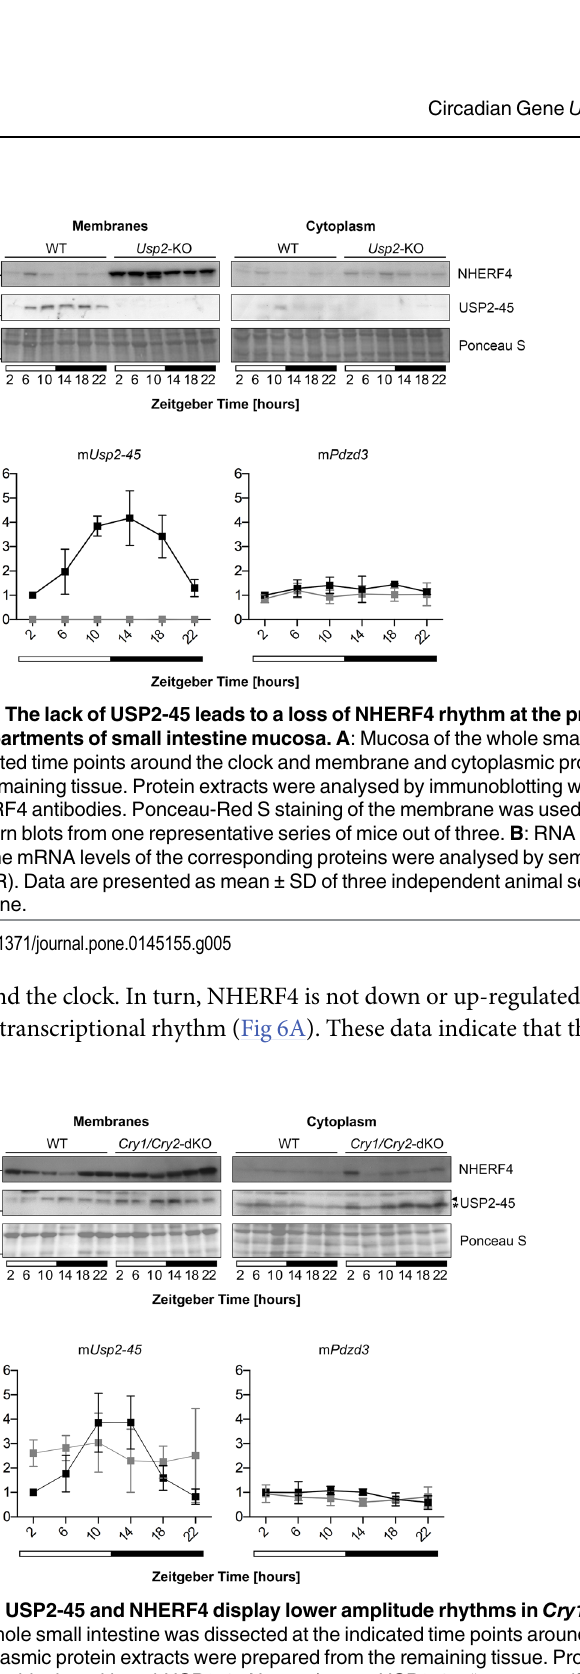
Fig 6. USP2-45 and NHERF4 display lower amplitude rhythms in Cry1/Cry2 -dKO mice. A : Mucosa of the whole small intestine was dissected at the indicated time points around the clock and membrane and cytoplasmic protein extracts were prepared from the remaining tissue. Protein extracts were analysed by immunoblotting with anti-USP2-45 N-term (arrow: USP2-45, * : non-specific) and anti-NHERF4 antibodies. Ponceau-Red S staining of the membrane was used as loading control. Data are western blots from one representative series of mice out of two. B : RNA was extracted from mid-jejunum and the mRNA levels of the corresponding proteins were analysed by semi-quantitative real-time PCR (qPCR). Data are presented as mean ± SD of three independent animal series. WT: black line, Cry1/Cry2 -dKO: grey